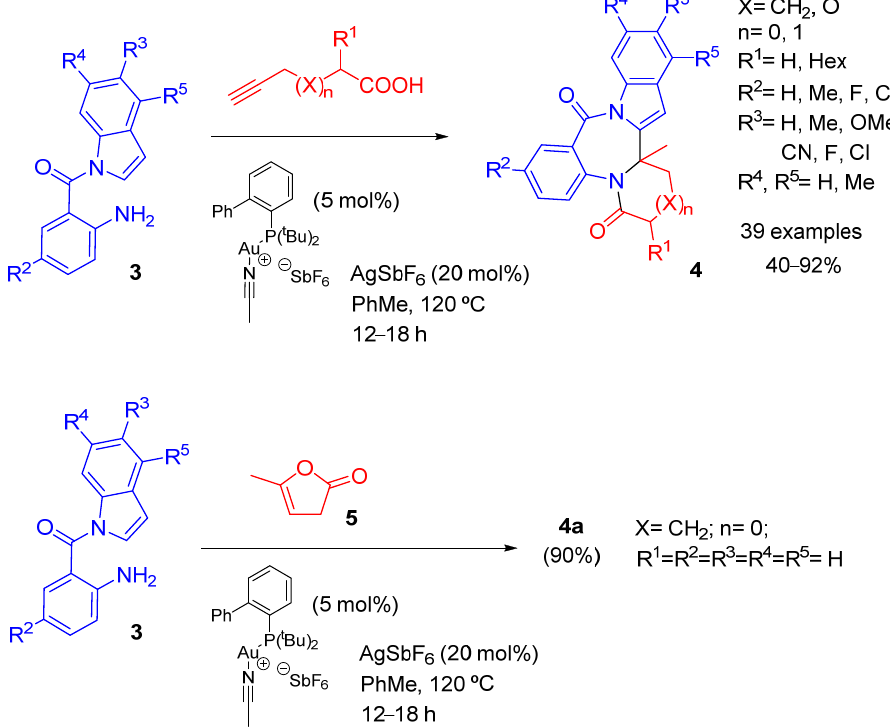
Scheme 6. Cascade reaction with aminophenyl)(1 H -indol-1-yl)methanone